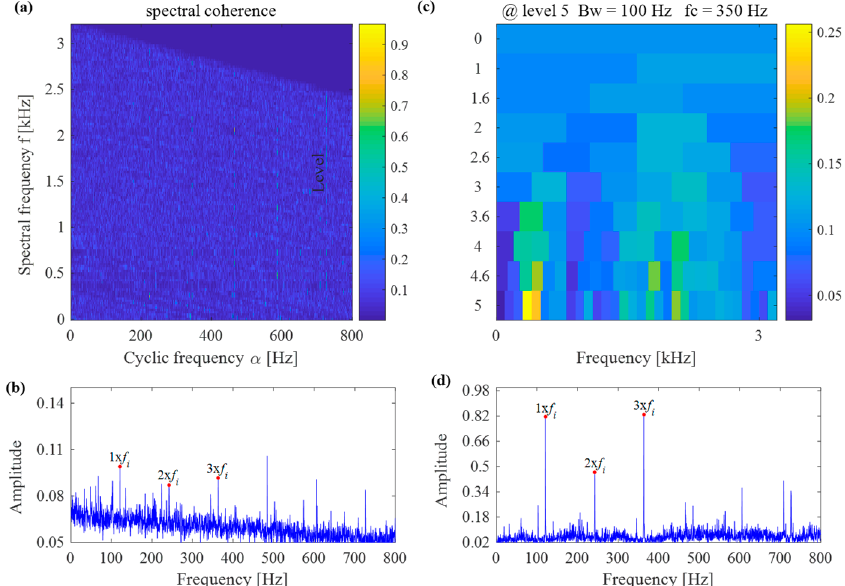
Figure 14. The EES and improved EES results of the signal as shown in Figure 13a. ( a ) Spectral